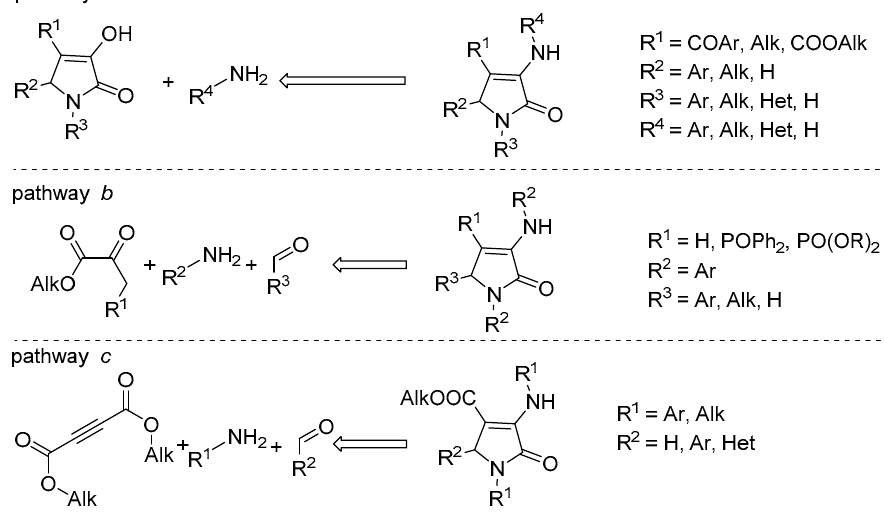
Scheme 1. Retrosynthetic pathways towards ADPs.